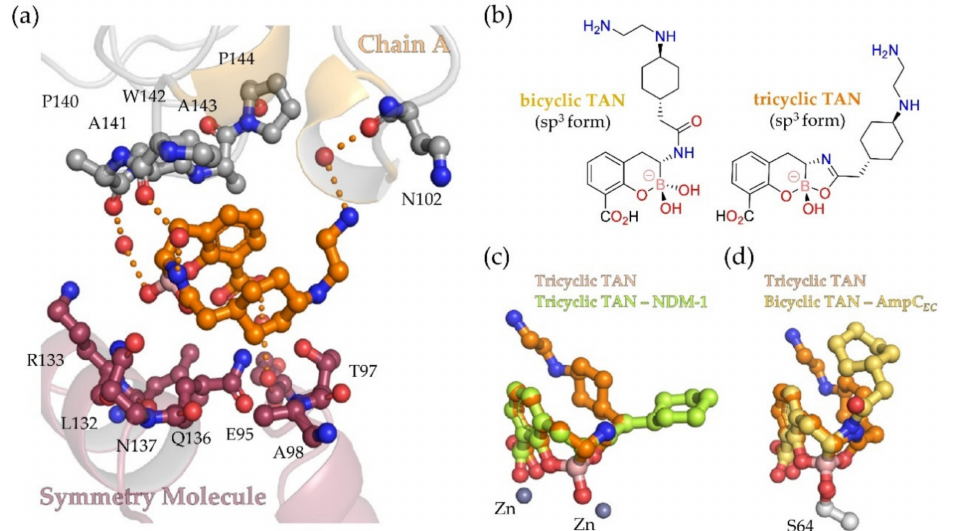
Figure 3. Comparison of bi- and tri-cyclic forms of sp 3 hybridized taniborbactam in complex with AmpC EC . ( a ) The tricyclic form of TAN as observed at the interface between symmetry related AmpC EC molecules along a three-fold rotation axis (see Figure S3a for overview, PDB ID 6YEN). Residues within 6 Å of TAN are shown as grey / purple sticks, hydrogen-bonding interactions as orange dashes, and waters as red spheres; ( b ) structures of proposed bi- and tricyclic sp 3 forms of TAN; ( c ) overlay of the ‘interface’ tricyclic TAN (AmpC EC , orange) with active site bound tricyclic TAN (NDM-1, green); ( d ) overlay of the ‘interface’ tricyclic TAN (AmpC EC , orange) with active site bound bicyclic TAN bonded to AmpC EC S64 (yellow). Note, with the MBL NDM-1 (PDB ID: 6RMF), both the bicyclic and the tricyclic forms were observed in one chain of the crystallographic dimer (chain A, shown here), while, in the second chain, only the tricyclic form was observed